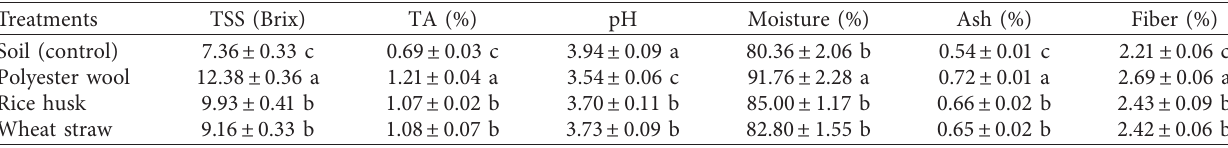
Table 4: Effect of different growth substrates on proximate nutrients of strawberry cv. Chandler.